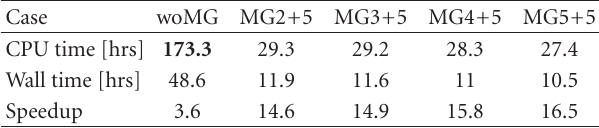
Table 4: Computational time of two-zone MG model with di ff erent combination of searching levels and skipping